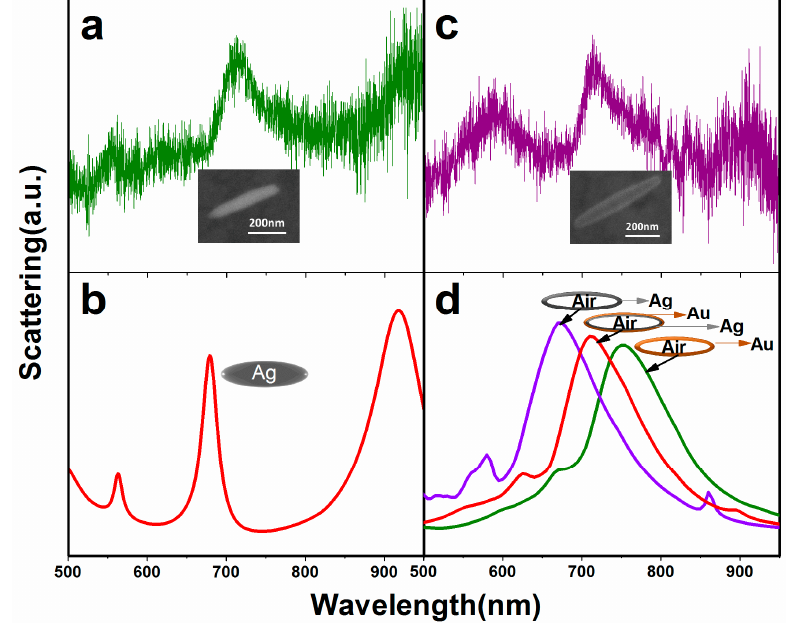
Figure 2. ( a ) Dark-field scattering spectra and corresponding SEM image (inset) of an Ag nanorice. ( b ) The corresponding simulation scattering spectra for the Ag nanorice with a 404 nm length and a 72 nm width. ( c ) Dark-field scattering spectra and corresponding SEM image (inset) of an Au–Ag nanorice. ( d ) The corresponding simulation scattering spectra of hollow nanorice with three different Au components.